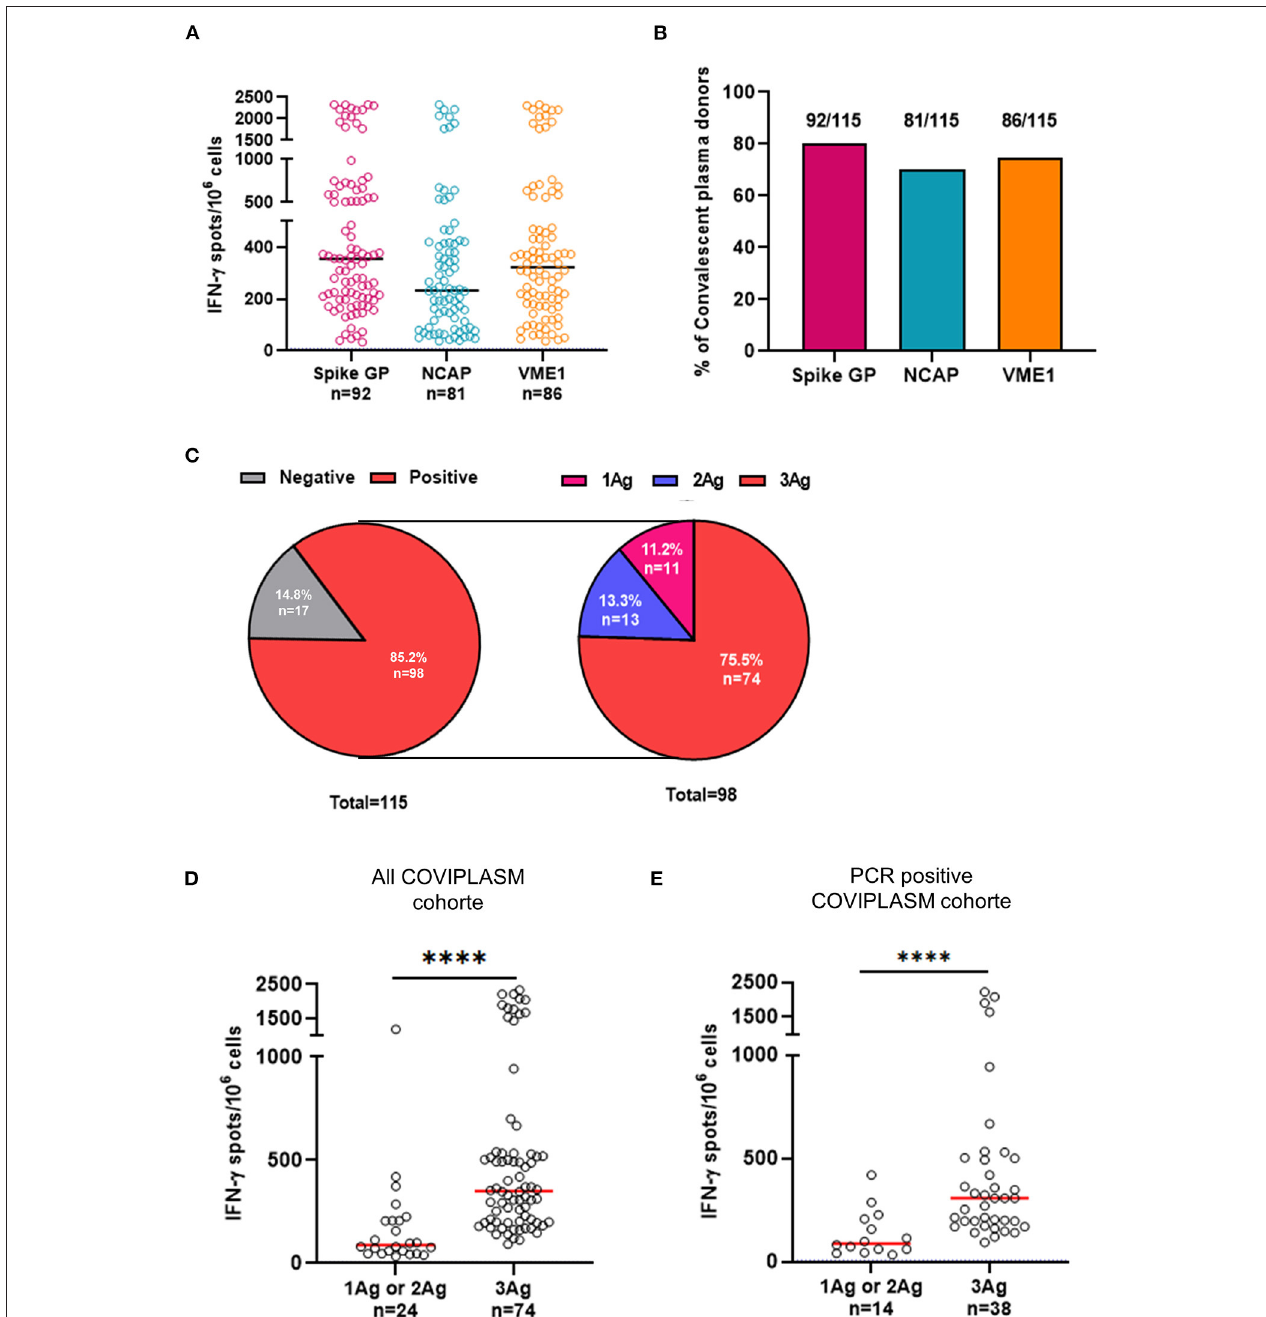
FIGURE 1 | Poly-specificity and magnitude of T cell responses against SARS-CoV-2 derived proteins. (A) Magnitude of positive IFN- γ + SARS-CoV-2 specific T cell responses in CPD. (B) Frequencies of CPD with T cell responses directed against the SARS-CoV-2. (C) Distribution of IFN- γ + SARS-CoV-2T cell responses (left pie-chart) and distribution of positive IFN- γ + SARS-CoV-2T cell responses against one, two or three SARS-CoV-2 proteins (right pie-chart). (D) Comparison of magnitude of positive responses against one or two SARS-CoV-2 proteins and that of positive responses against the three proteins in all COVIPLASM cohort. (E) Comparison of magnitude of positive responses against one or two peptides derived from SARS-CoV-2 proteins and that of positive responses against the three peptides in the PCR positive COVIPLASM cohort. Mann-Whitney test, **** P < 0.0001. Ag, antigen; CPD, convalescent plasma donor; NCAP, nucleocapsid; VME1, membrane